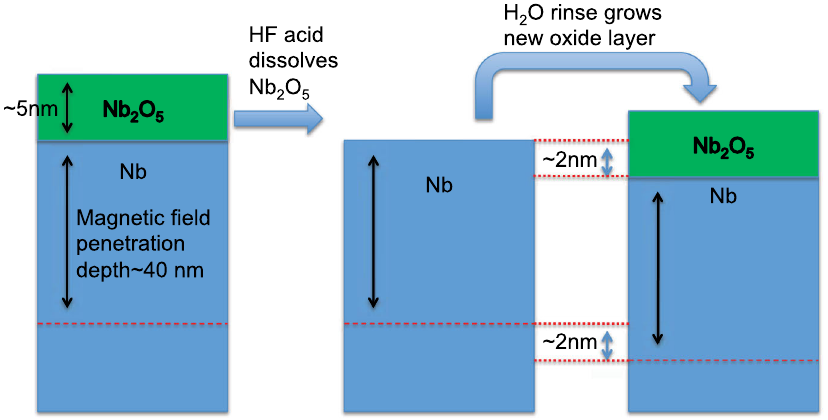
FIG. 1. Schematic of the nanoremoval during a single HF/water rinse cycle.